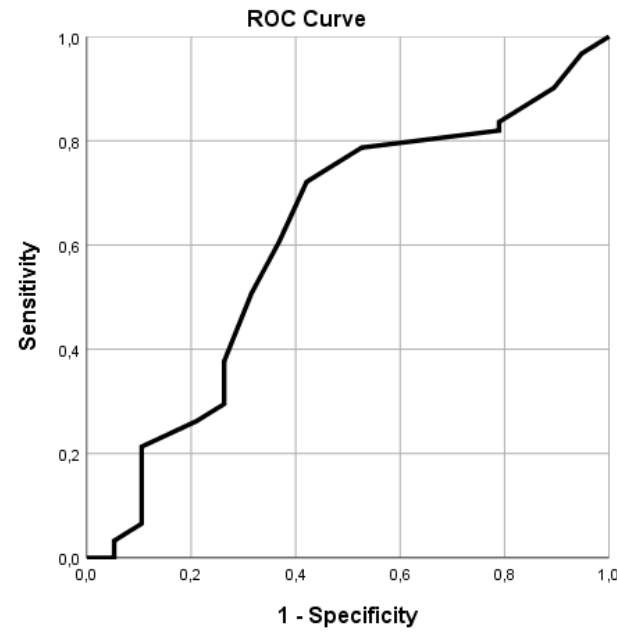
Fig. 4 – ROC curve for the preoperative LAD values – sinus rhythm in the first month. LAD=left atrial diameter; ROC=receiver operating characteristics.